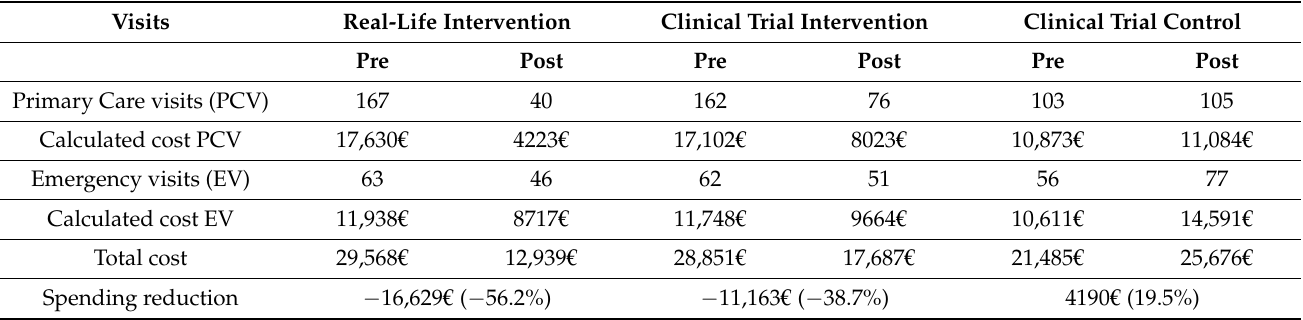
Table A2. Health cost rates before and after the Real-Life and Clinical Trial interventions.